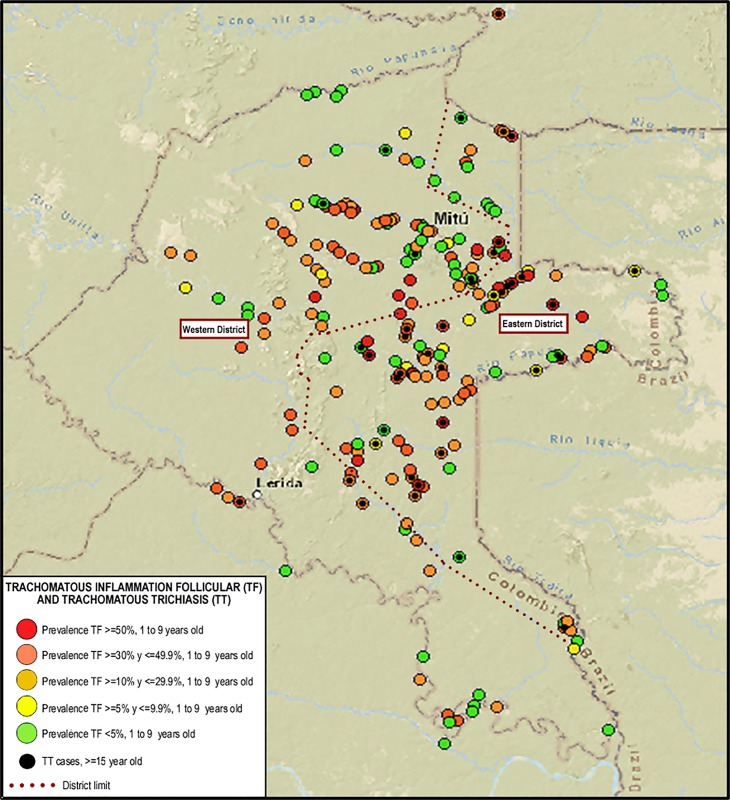
Geographic distribution of TF according to prevalence range by community and cases of TT.Fig 2 was created for this publication using shapefiles from the USGS LandLook database (http://landsatlook.usgs.gov/), December 2018 and QGIS 2.18.14.